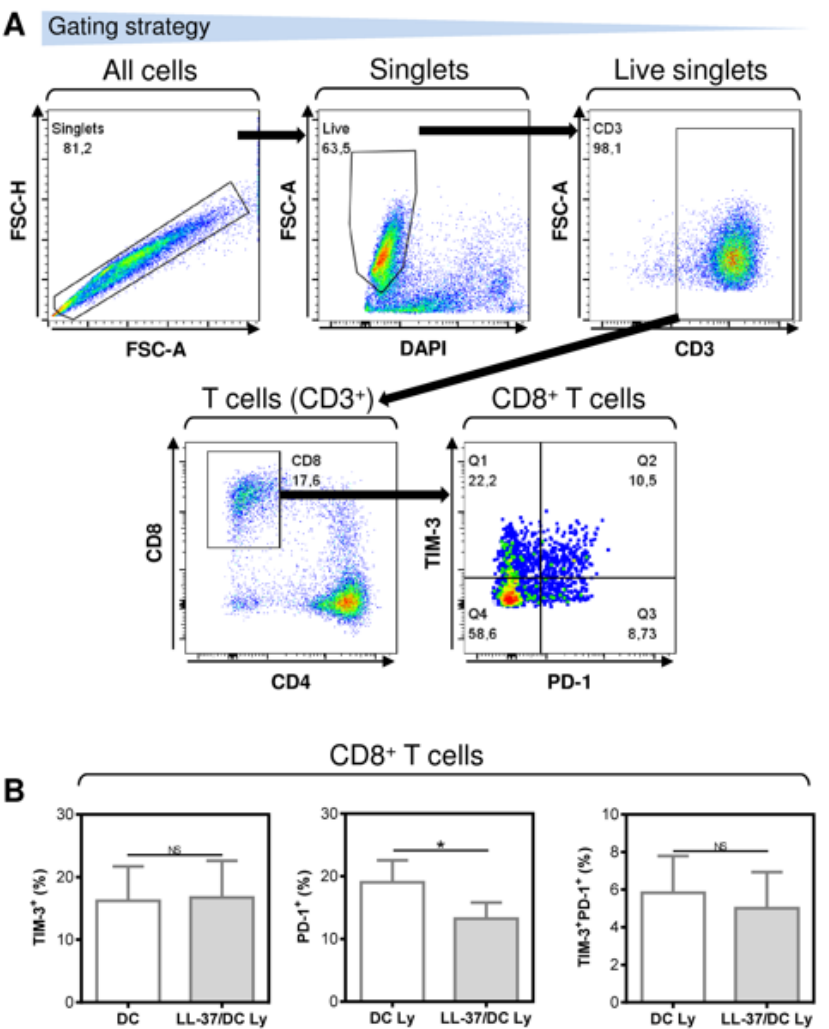
Figure 3. The application of LL-37 during DC production (differentiation, pulsation, and maturation) significantly downregulated the surface expression of PD-1 but not TIM-3 in CD8 + T cells of DC-stimulated autologous lymphocytes. ( A ) The gating strategy of flow cytometry data. ( B ) The expression of TIM-3, PD-1, and TIM-3 together with PD-1 in the 14-day autologous lymphocytes stimulated with DCs (DC Ly), or DCs produced in the presence (differentiation, pulsation, and maturation) of LL-37 (LL-37/DC Ly). In ( B ), mean + SEM and significances of differences between the group of DC Ly and LL-37/DC Ly samples are indicated ( NS p > 0.05, * p < 0.05; n = six donors; paired two-tailed Student’s t -test).